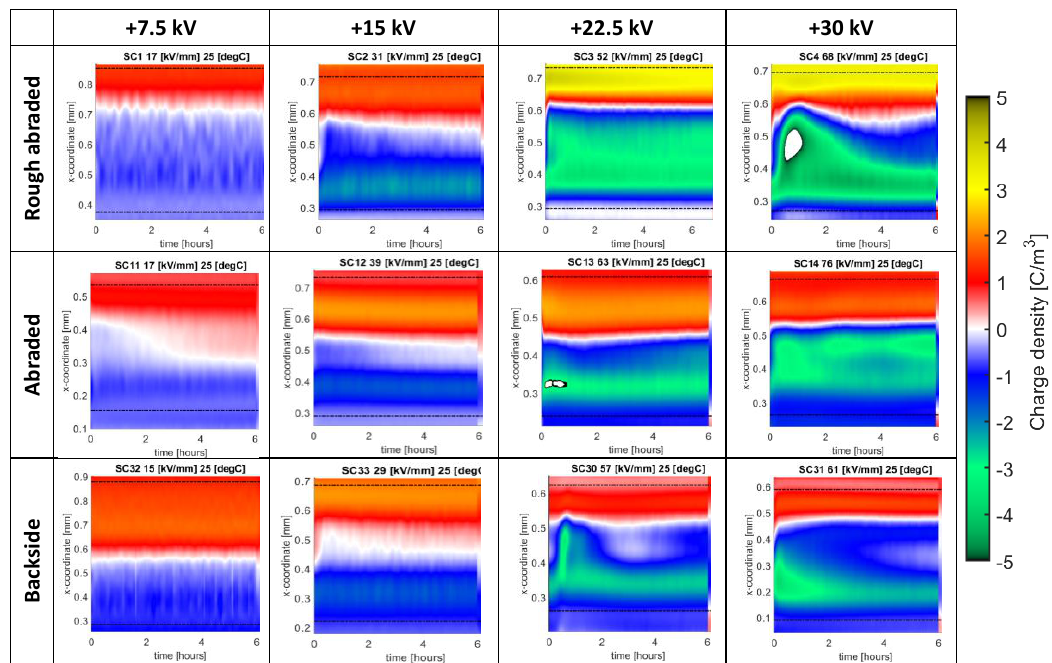
Figure 7. PEA measurements at 25 °C, using different poling voltages, polarization sequence only. All samples feature the listed surface type as anode (top) and a backside cathode (bottom). The peaks positioned at the anode and cathode have been removed by gaussian peak removal. White regions correspond to charge densities beyond ±5 C/m 3.